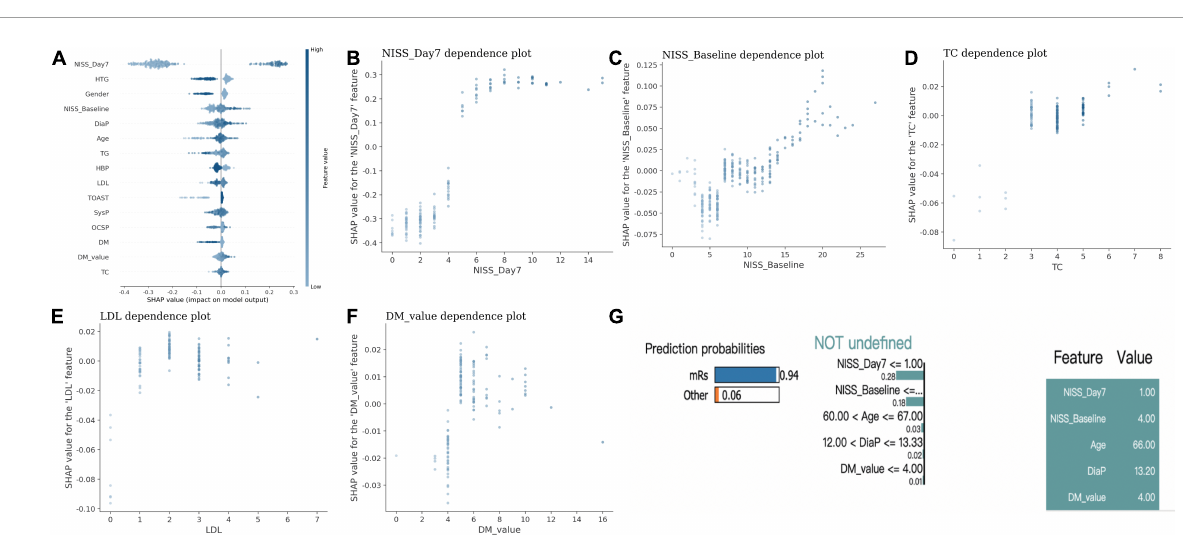
FIGURE2 The explainable AI model in the outcome prediction in IS. (A) The SHAP p -value of each factor to differentiate the outcome in IS. (B–F) The scatter plot between each specific factor and its SHAP p -value. (G) One example of patient shows lower NIHSS_Day 7, lower NIHSS_Basline, lower age, DiaP and DM- p -value had a higher probability of good outcome with LIME